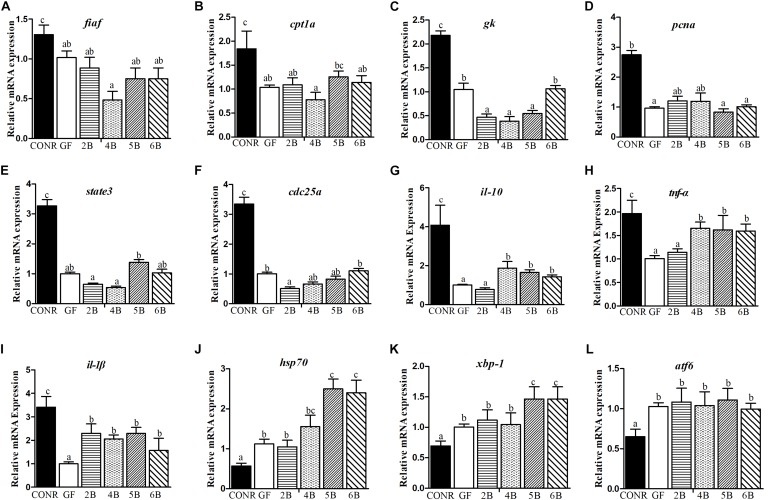
Comparisons of gene expression levels among germ-free (GF) zebrafish, CONR zebrafish and mono-associated (GF) zebrafish with different concentrations of B. subtilis WB800N. (A) The expression levels of nutrients metabolism related genes fiaf, (B)
cpt1a, (C)
gk. (D) The expression level of cell proliferation related genes pcna, (E)
state3, (F)
cdc25a. (G) The expression levels of innate immune related genes il-10, (H)
tnf-α and (I)
il-1β. (J) The expression levels of damage stress related genes hsp70, (K)
xbp1 and (L)
atf6. The results were shown as mean ± SEM of three independent experiments with six replicates for each experiment, n = 90, per group. Different letters indicate statistically significant differences among groups (p < 0.05).